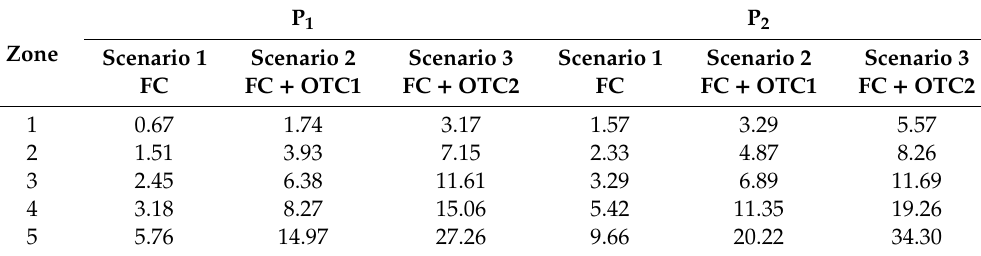
Table 6. Initial demand function points for the HNP (P 1 and P 2